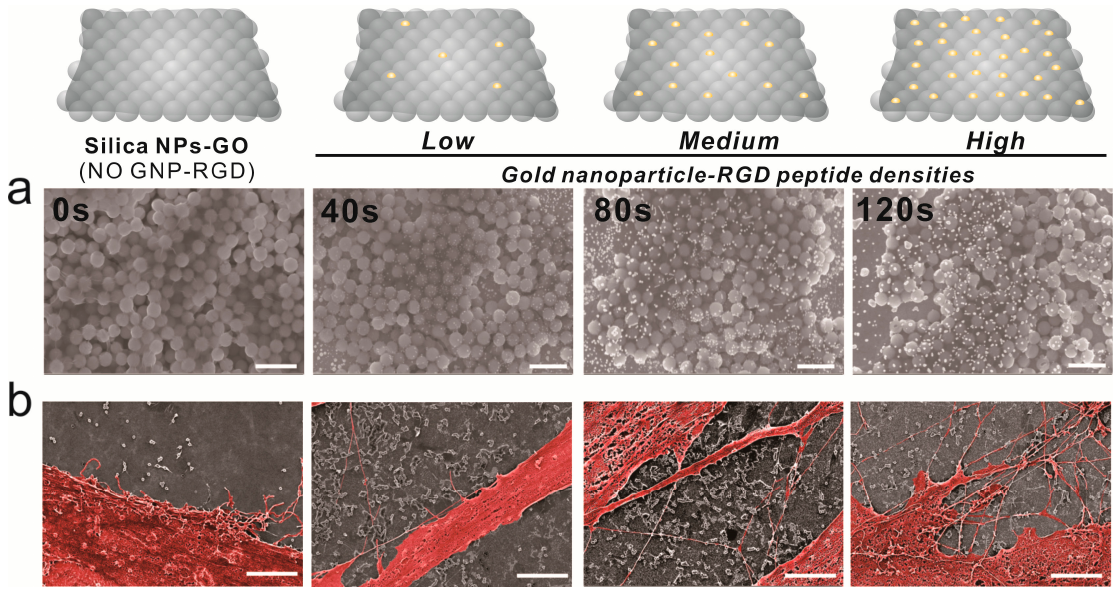
Figure 3. Scanning electron microscopy (SEM) images of ADSCs on gold-deposited substrates. ( a ) From left to right, SEM images of gold deposition. Scale bars = 1 μ m. ( b ) Pseudocolor SEM images of ADSCs showing cell spreading. Scale bars = 3 μ m.